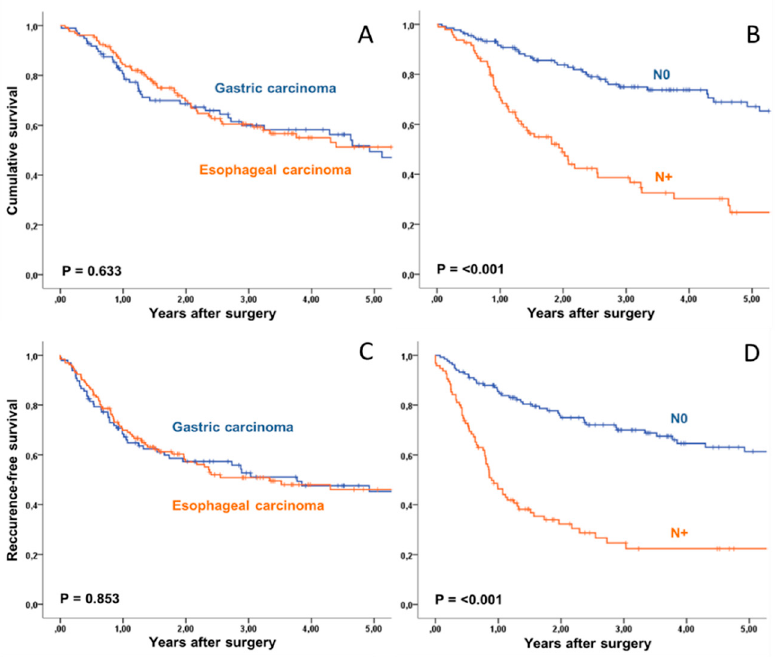
Figure 1. Survival in patients with esophagogastric adenocarcinoma after therapy with 5-FU, Leucovorin, Oxaliplatin and Docetaxel (FLOT) and surgical resection. Overall survival ( A ) and recurrence-free survival ( B ) of 131 patients with esophageal carcinoma and 97 patients with gastric carcinoma were similar. Nodal involvement (N + , n = 153) was the major predictor of overall survival ( C ) and recurrence-free survival ( D ).